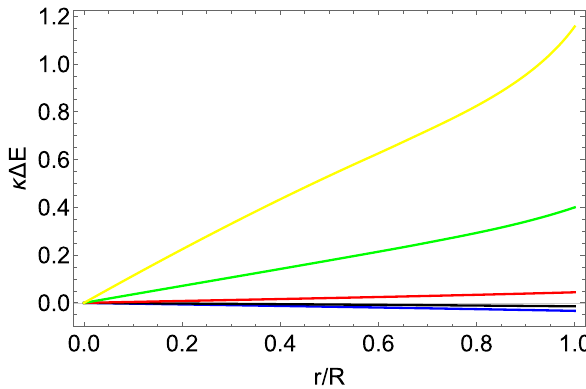
Fig. 5 v for u = 0 . 1 (blue line), u = 0 . 2 (black line), u = 0 . 3 (red line), u = 0 . 37 (green line) and (cid:13) = 1